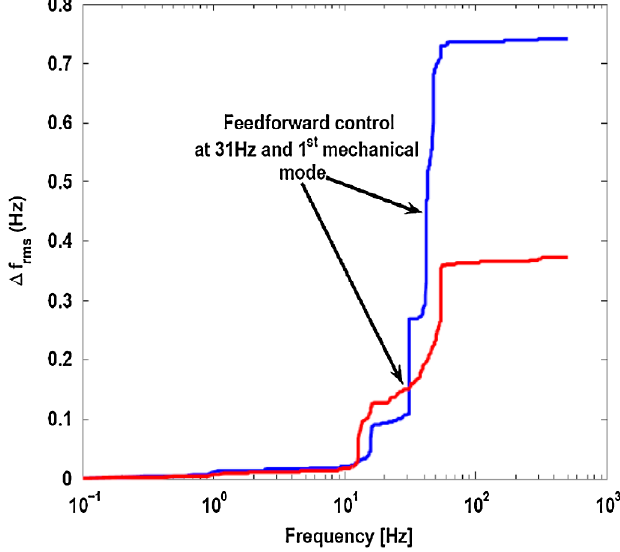
FIG. 17. (Color) Integrated detuning spectra of open loop detun- ing (blue curve), feedback controlled detuning (red curve), and residual detuning with feedback and feedforward compensation (black